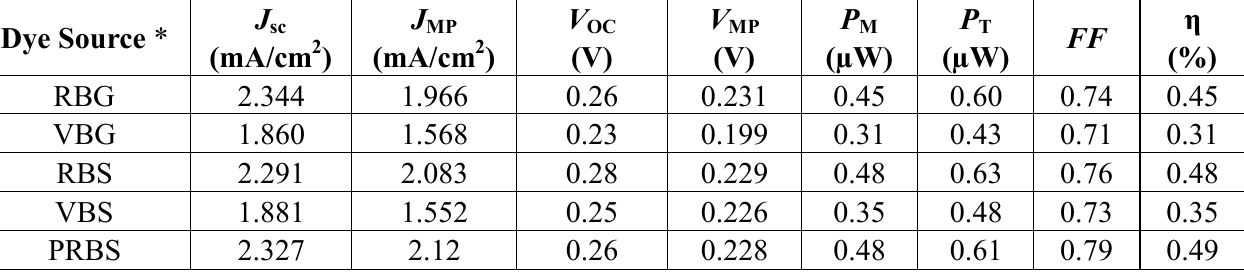
Table 1. Electrical characterization of all prepared